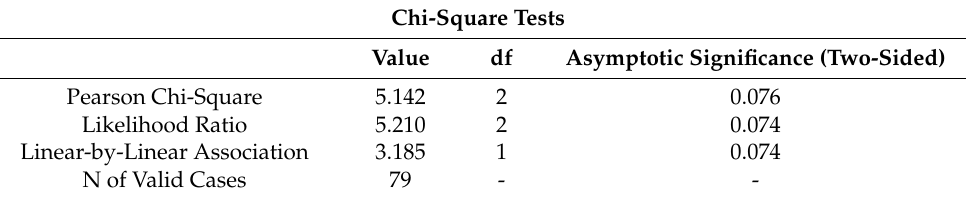
Figure 4. First main problems. Table 3. Results of Chi-square test for variables role and first main